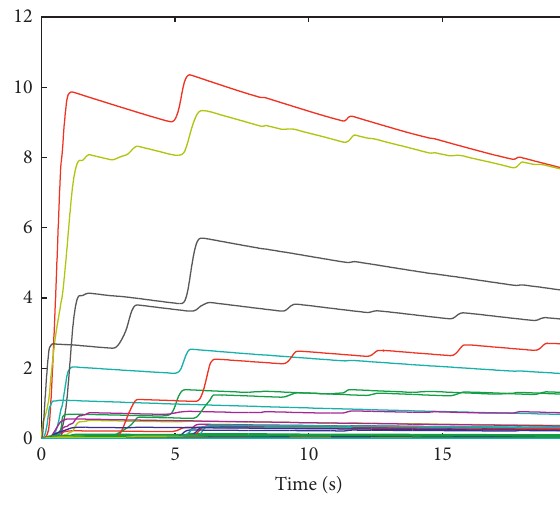
Figure 6: Fuzzy parameter for θ